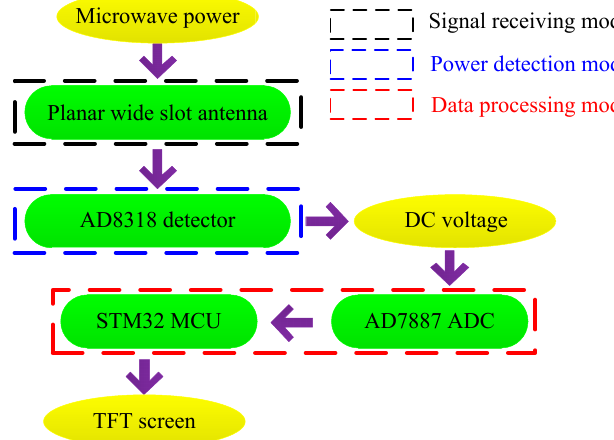
Figure 1. Principle of this detection system.